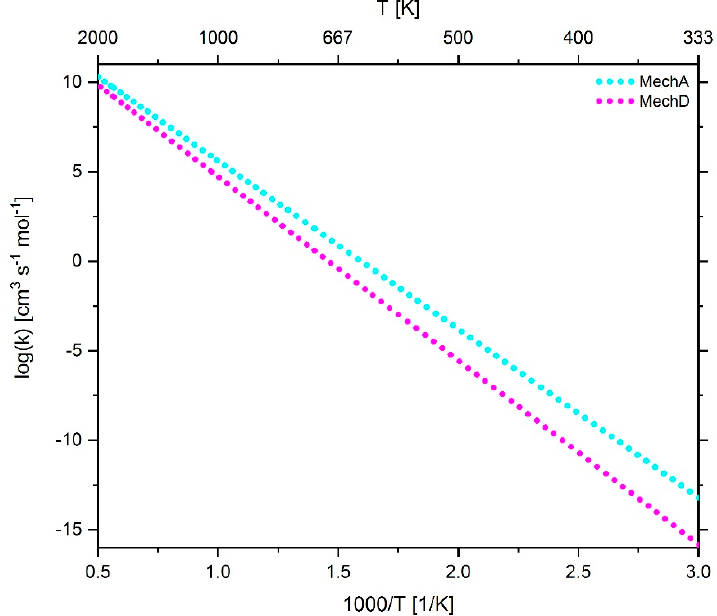
Figure 16. Comparison of the reaction rate coe ffi cient of reaction 248 (OC 3 H 5 OOH ↔ CH 2 CHO + CH 2 O + OH) of MechA and MechD.